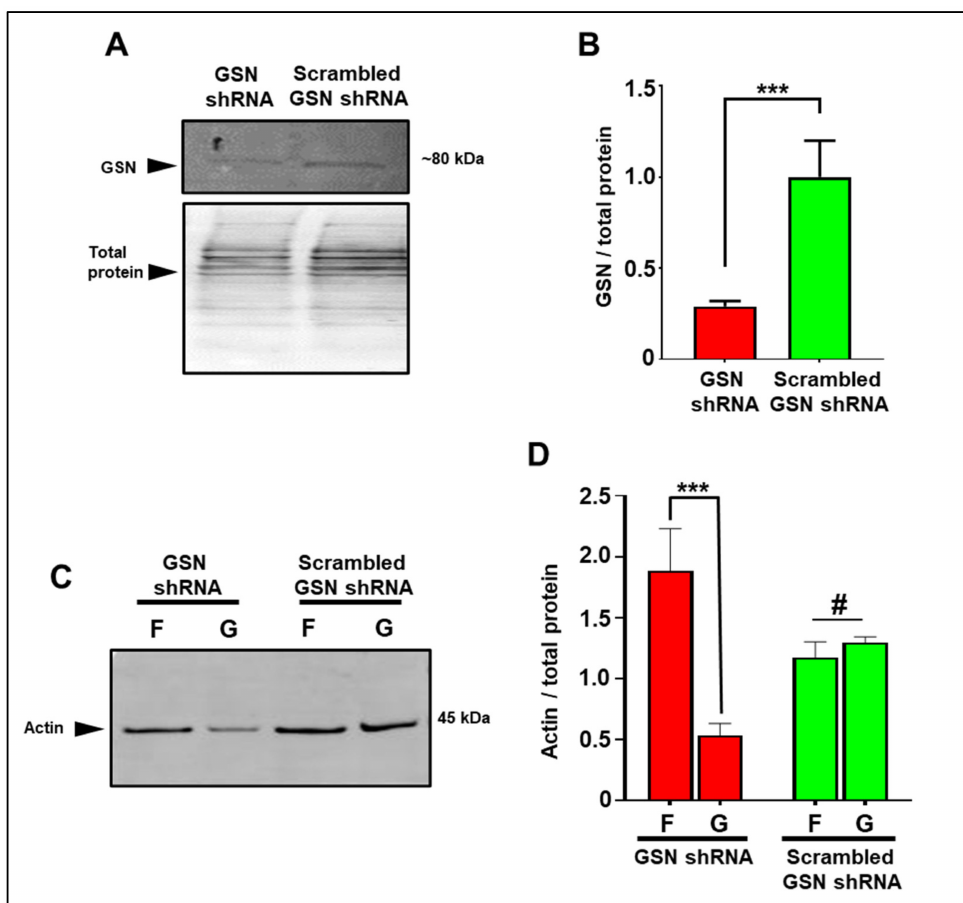
Figure 4. Relationship between GSN and cytoskeletal remodeling. ( A,B ) Efficiency of GSN shRNA knockdown vs. scrambled GSN shRNA in MEF-STIM1-BioID. ( B ) Barr graph quantification of GSN knockdown. ( C ) Reorganization of actin, F-actin—F and G-actin—G in MEF-STIM1-BioID transfected with GSN targeting shRNA or scrambled shRNA. ( D ) Quantification analysis of G-actin and F-actin. GSN knockdown resulted in a potent accumulation of F-actin. Error bar = SD, # p > 0.05, *** p <